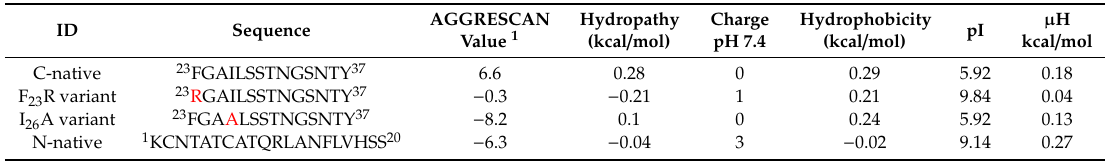
Table 1. Physicochemical parameters of evaluated